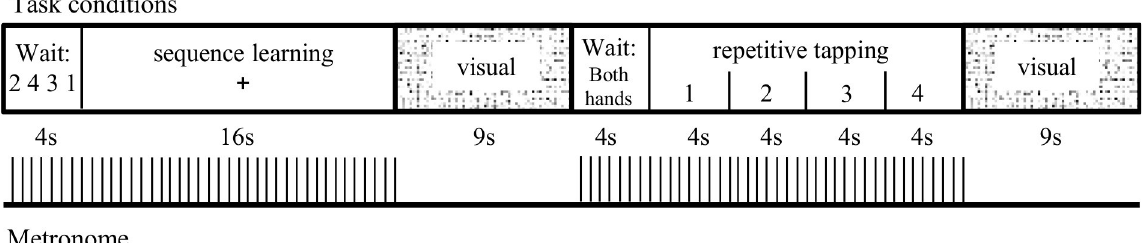
Fig 1. One cycle of the visual / motor task. Including their instruction screens, two motor conditions alternated with a visual condition; this sequence repeated for a total of six cycles. Motor conditions were accompanied by a metronome ticking at two beats per sec for pacing finger